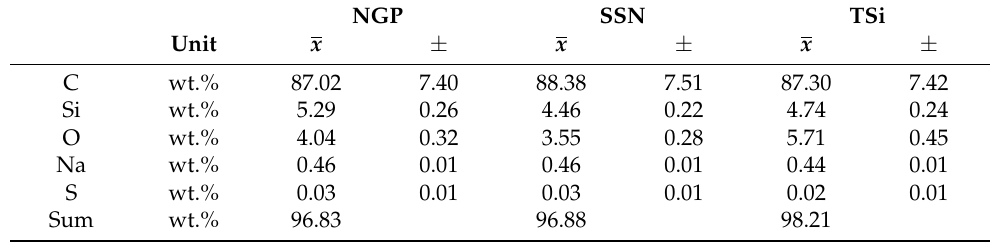
Measurement uncertainty was calculated based on DIN ISO 11352 with coverage factor k = Table 4. Chemical composition of the manufactured electrodes measured by ICP-OES and CGHE.